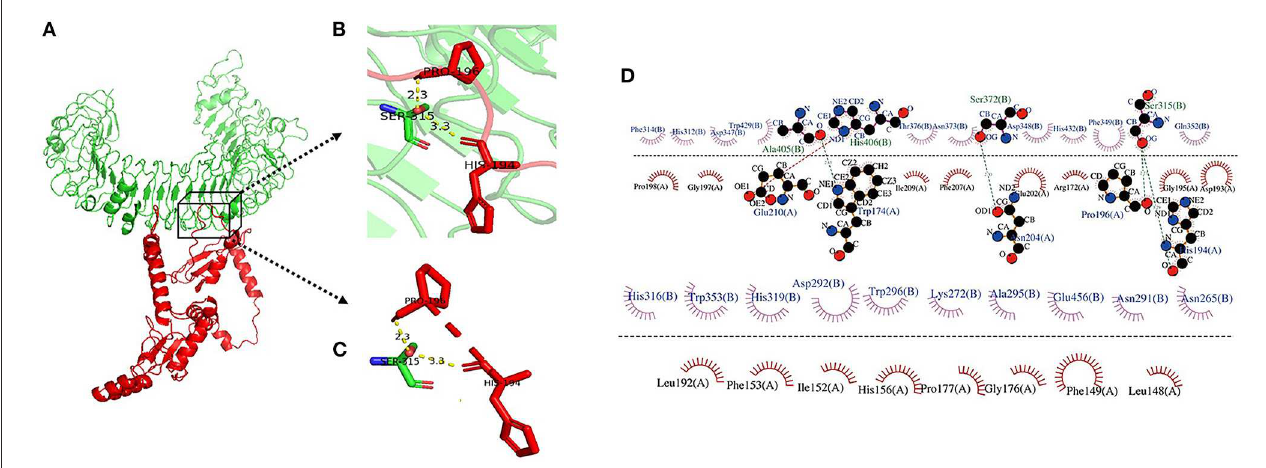
FIGURE8 Complexes of candidate vaccine protein docking with human TLR3 receptor. (A) Epitope vaccine structure is shown in blue and TLR3 in green; (B) Residue of interaction between docking TLR3 and epitope vaccine; (C) Local magnification highlights amino acid residues; (D) LigPLot + determined two-dimensional interaction diagram.